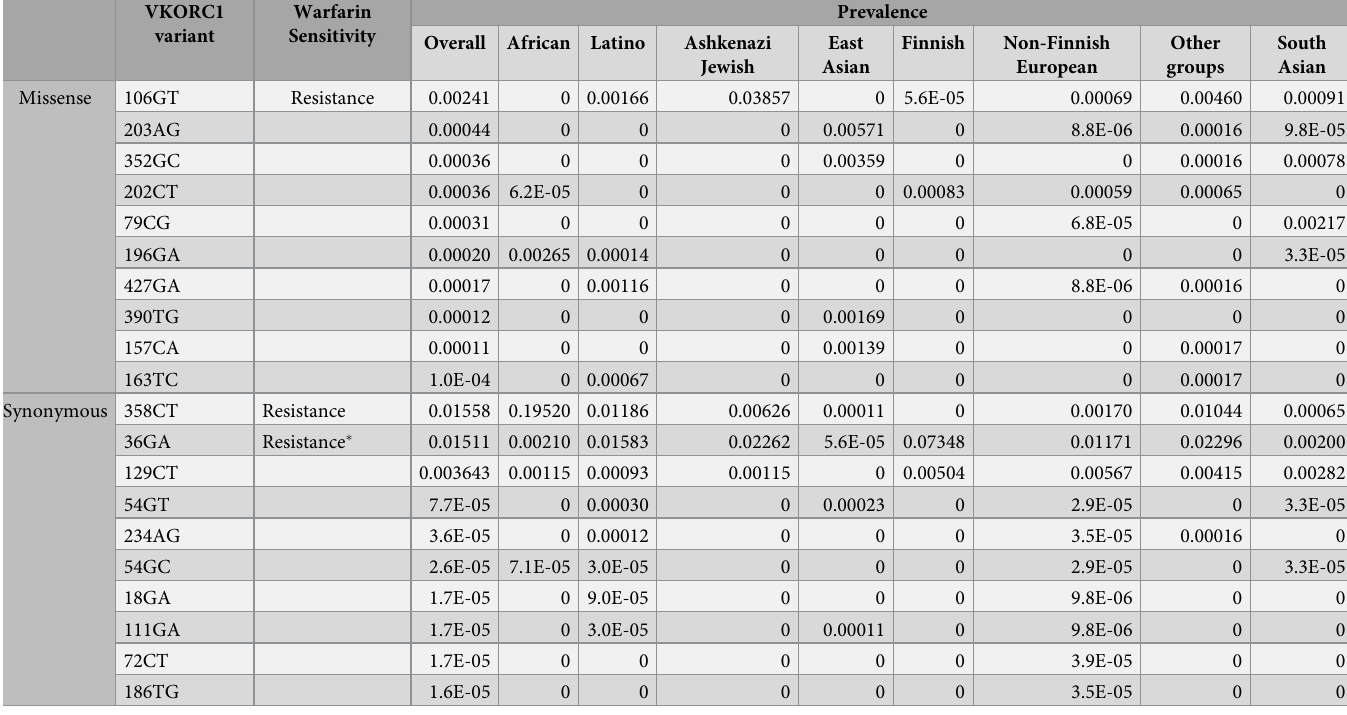
Table 5. Population frequencies of missense and synonymous VKORC1